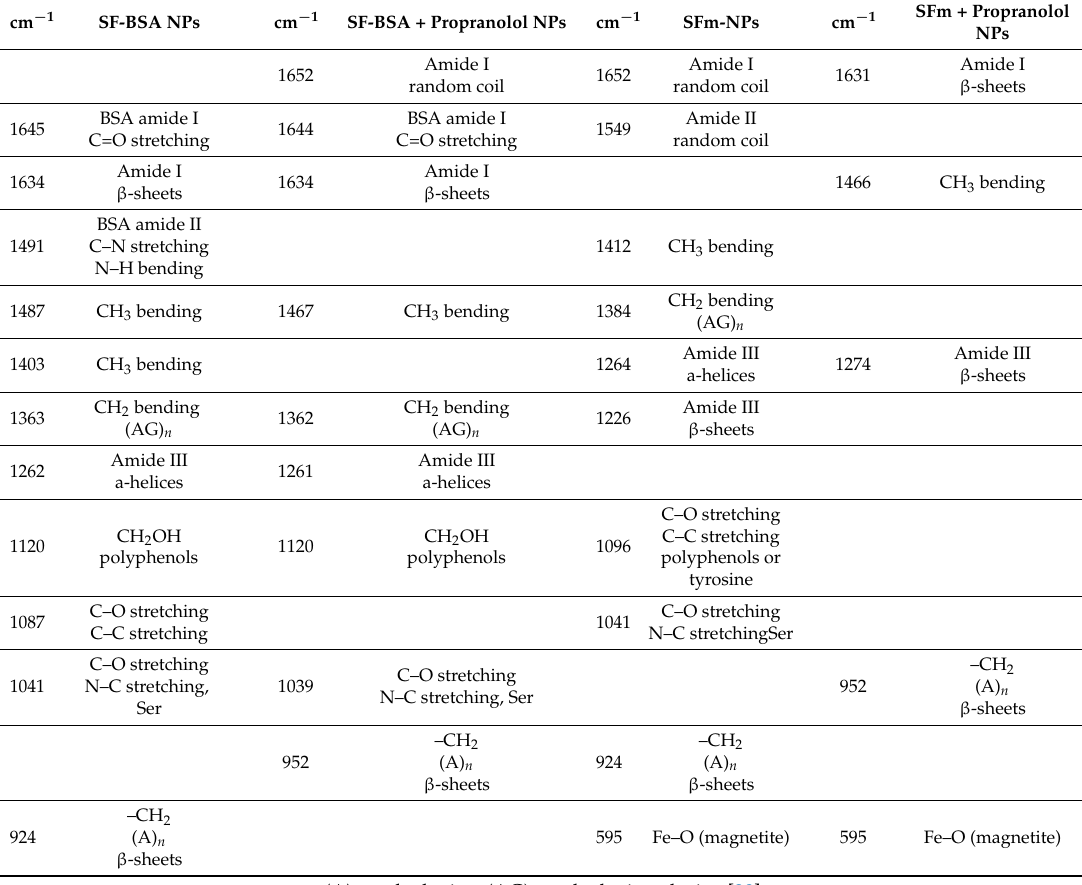
Table 7. Assignment of the main bands present in SF-BSA NPs, SF-BSA + propranolol NPs, and SFm and SFm + propranolol